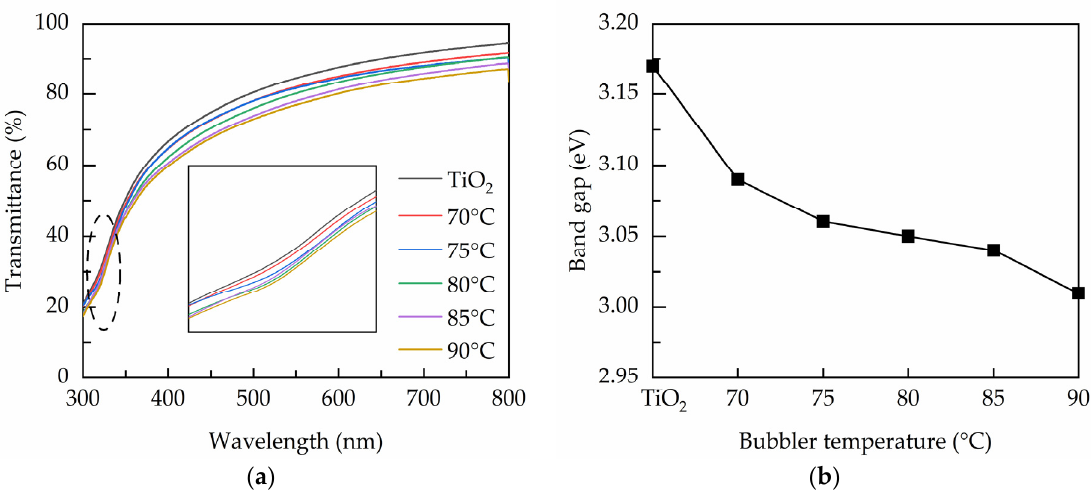
Figure 2. ( a ) Transmittance spectra and ( b ) band gap of the PEALD films prepared with various bubbler temperatures.